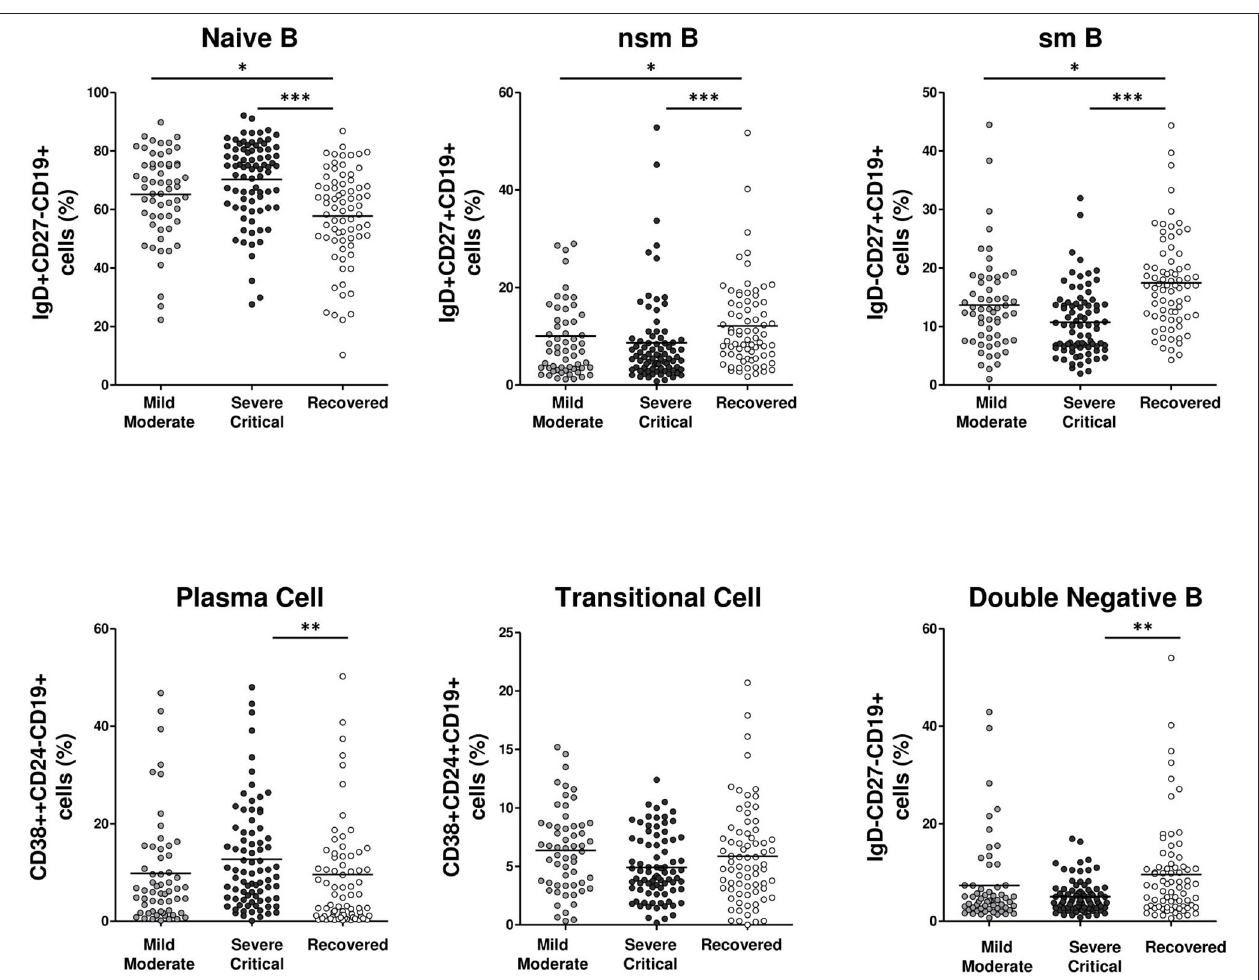
FIGURE 4 | Lower memory and “double negative” and higher naive and plasma B cells frequency in severe/critical COVID-19 patients. Frequency of peripheral blood B cell populations in mild/moderate (light gray circles), severe/critical (dark gray circles) and recovered (white circles) groups of patients. Each dot represents